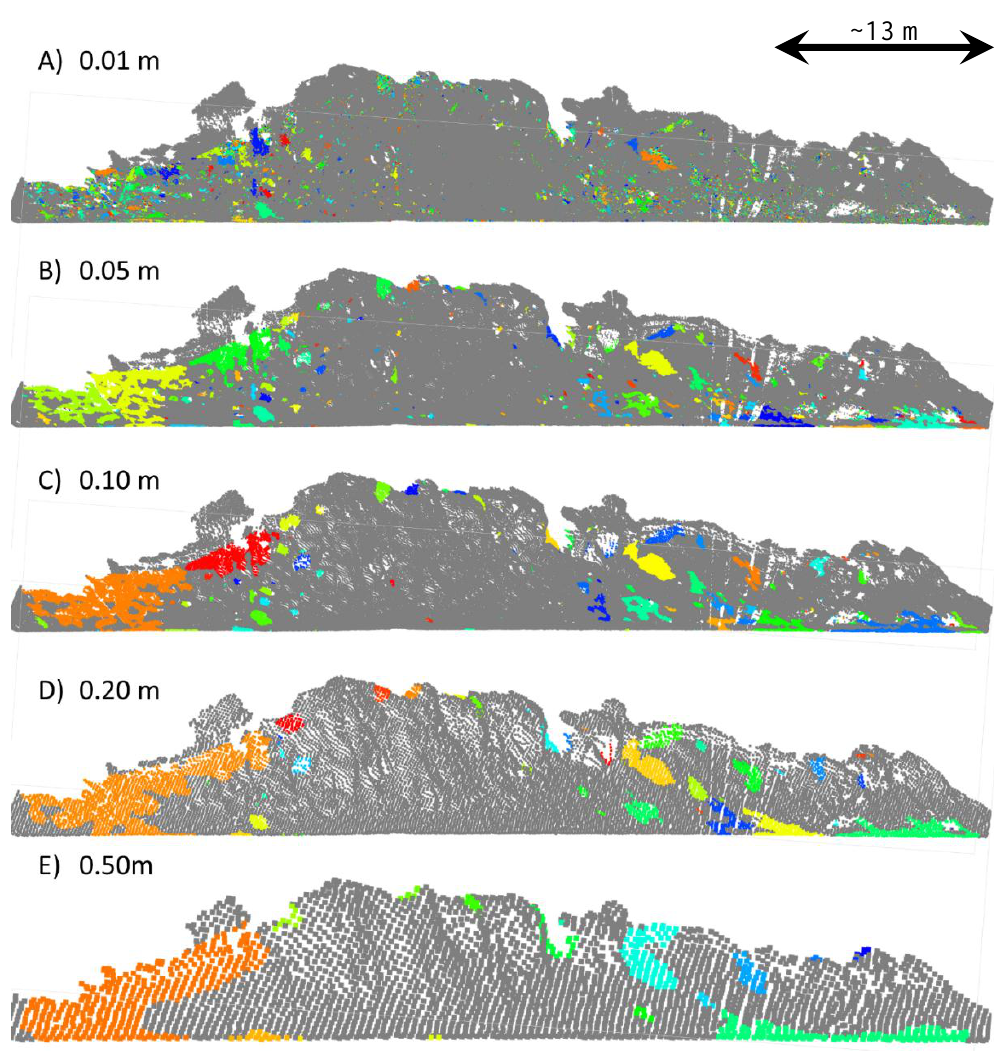
Figure 8 shows a sample triangulated shaded relief surface model with all holes filled for Site A. This model was generated with a 0.05 m cell size and adequately preserves the blocky rock mass features present across the slope. Analysis indicated that 13% (2014) to 15% (2013 data) of rock slope surface area was comprised of filled holes. Figure 9 shows the rockfall clustering results with resolutions ranging from 0.01–0.50 m without hole filling. As expected, the size of the change clusters increases for the coarser resolution models.